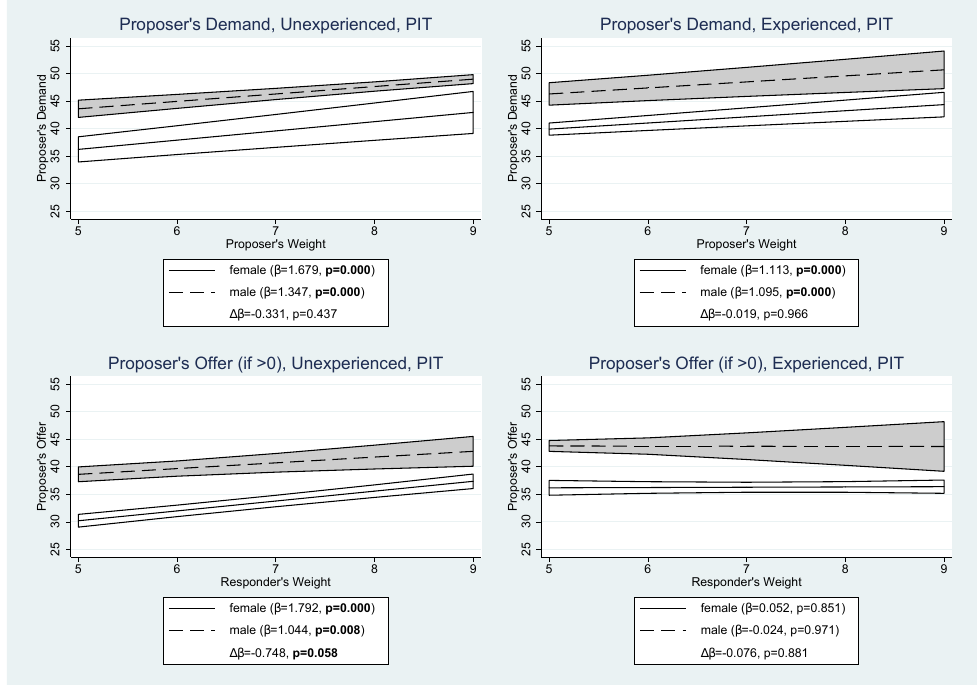
Figure 4. Marginal Effect of Nominal Voting Weight on Proposer Behavior by Role, Experience, and Gender. Upper panel: average demand in tokens; lower panel: average offer (if < 0) in tokens. β and ∆ β are the marginal effect of the nominal voting weight and the differential slope of Gender { 1 = male } estimated by a random effects panel regression. p is the significance level. Shaded areas represent 90% confidence intervals around the